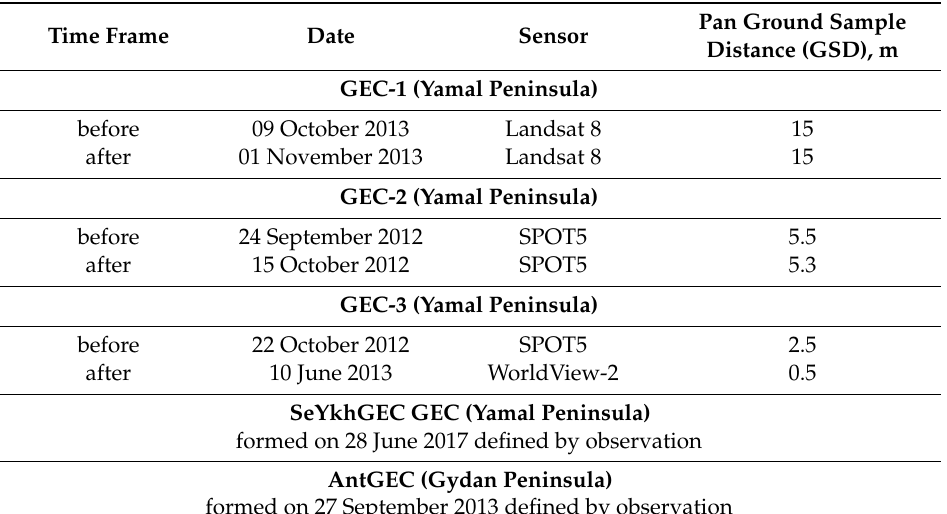
Table 1. Gas emission craters formation timeframe.